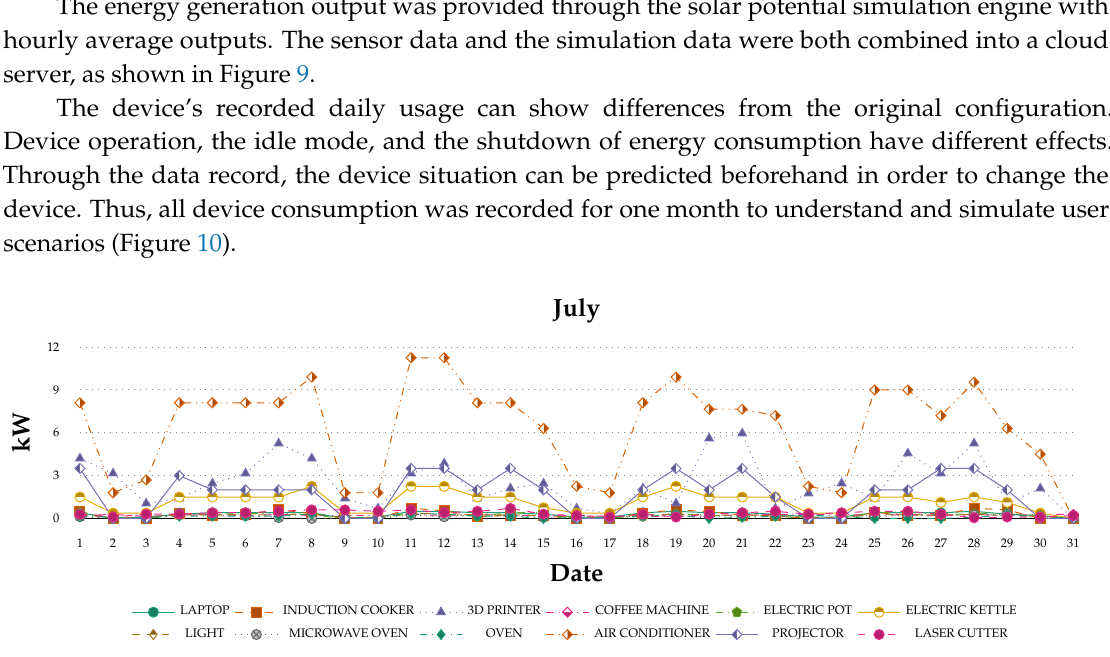
Figure 10. Monthly of every device